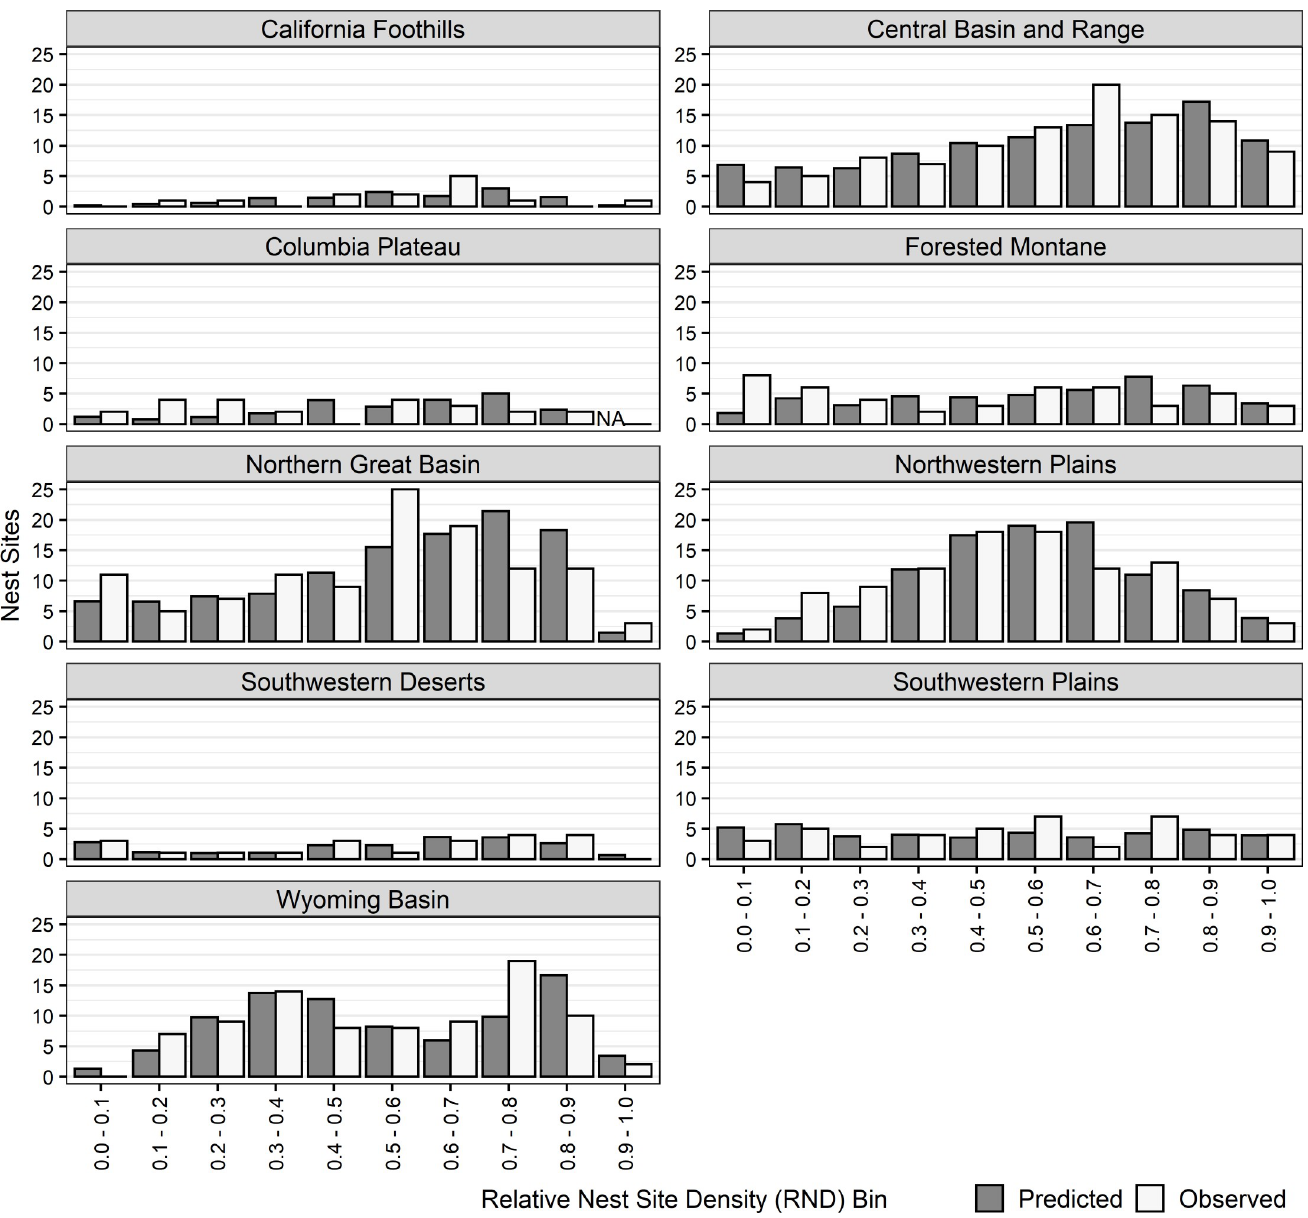
Fig 4. Bar chart of distribution of observed and predicted nests sites (observed–predicted) within RND bins for 553 independent nest sites within nine modeling regions.